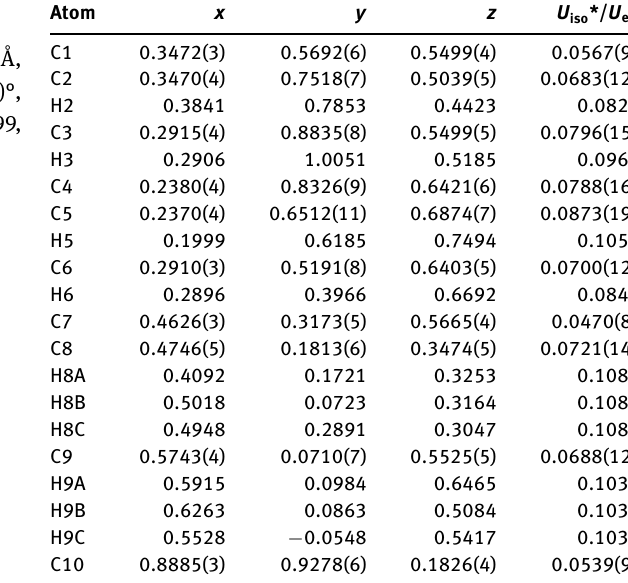
Table 2: Fractional atomic coordinates and isotropic or equivalent isotropic displacement parameters (Å 2